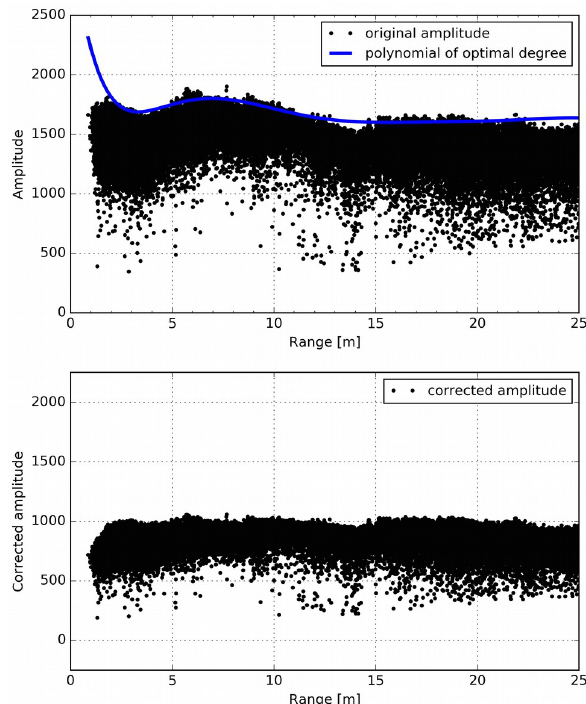
Figure 6. Amplitude correction of the complete scan point cloud using a polynomial derived from spheres. Top: Original amplitudes with blue line visualizing the polynomial from spheres. Bottom: Amplitudes corrected with the polynomial from